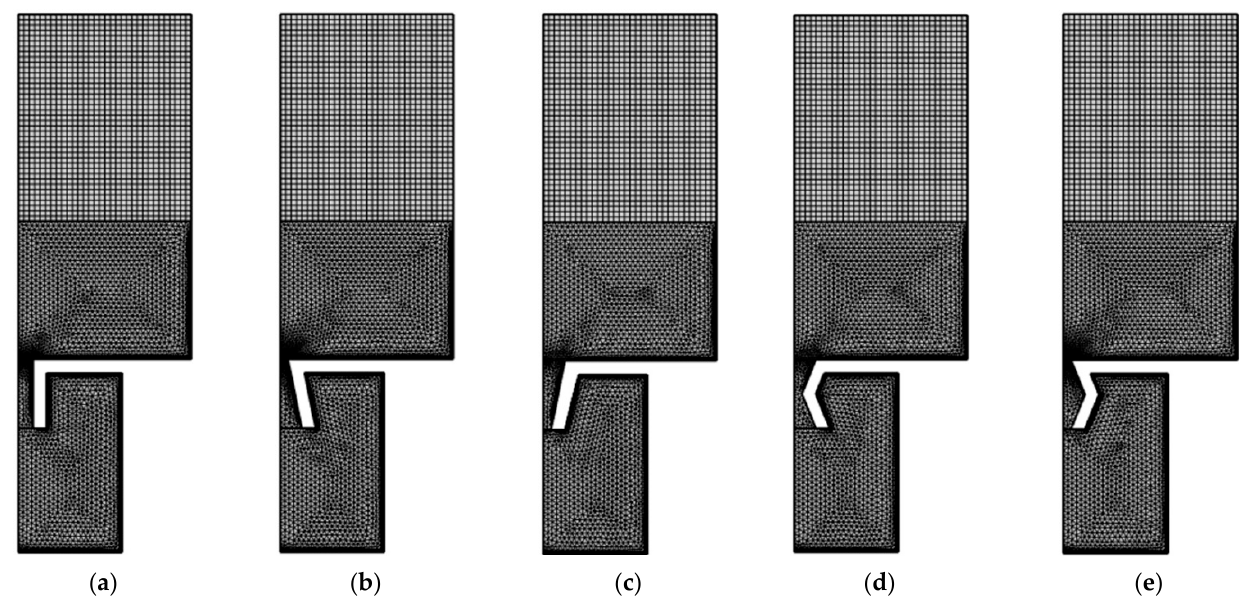
Figure 6. The meshed model for the HRs with an aperture for various tangent sectional shapes. ( a ) Rectangle; ( b ) common trapeziform; ( c ) reverse trapeziform; ( d ) dumbbell; and ( e ) olive.